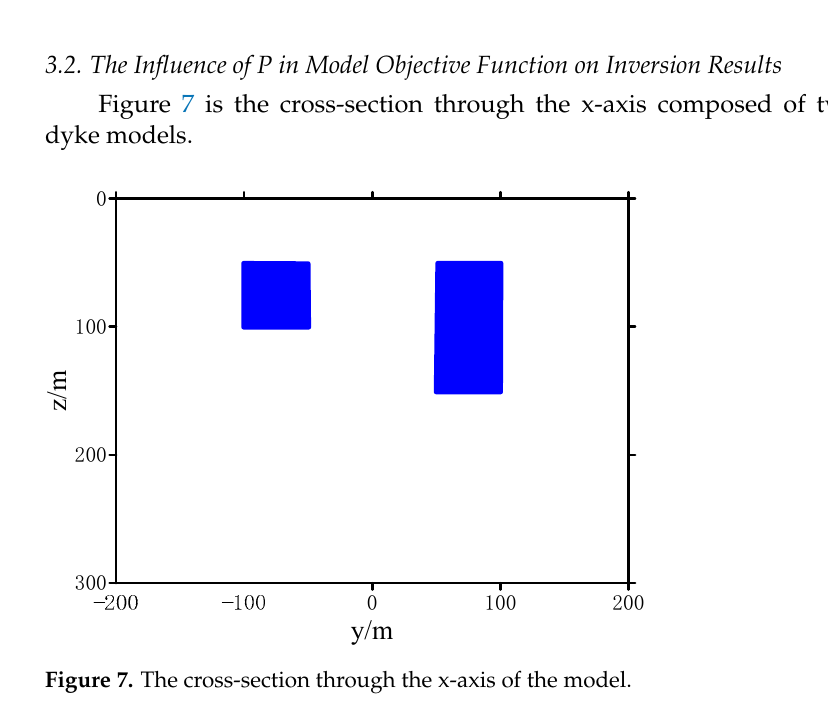
Figure 6. The smooth and non-smooth inversion results of Model 1 and Model 2. ( a ) The smooth = 1 ), ( b ) the smooth inversion of Model 1 ( (cid:1868) inversion of Model 1 ( (cid:1868) (cid:3033) inversion of Model 1, ( d ) the smooth inversion of Model 2 ( (cid:1868) = 2 ), ( f ) the non-smooth inversion of Model 2. Model 2 ( (cid:1868) (cid:3033)